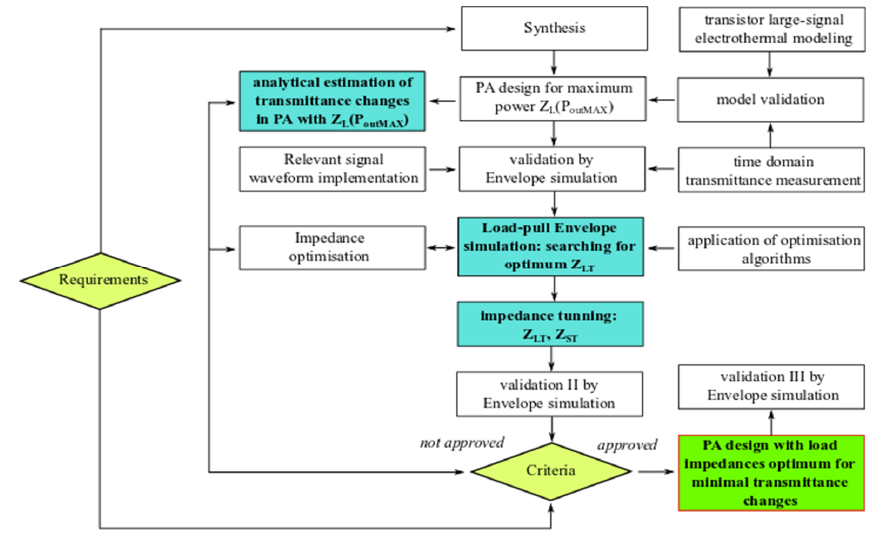
Figure 14. Simplified guidelines for proposed design methodology.